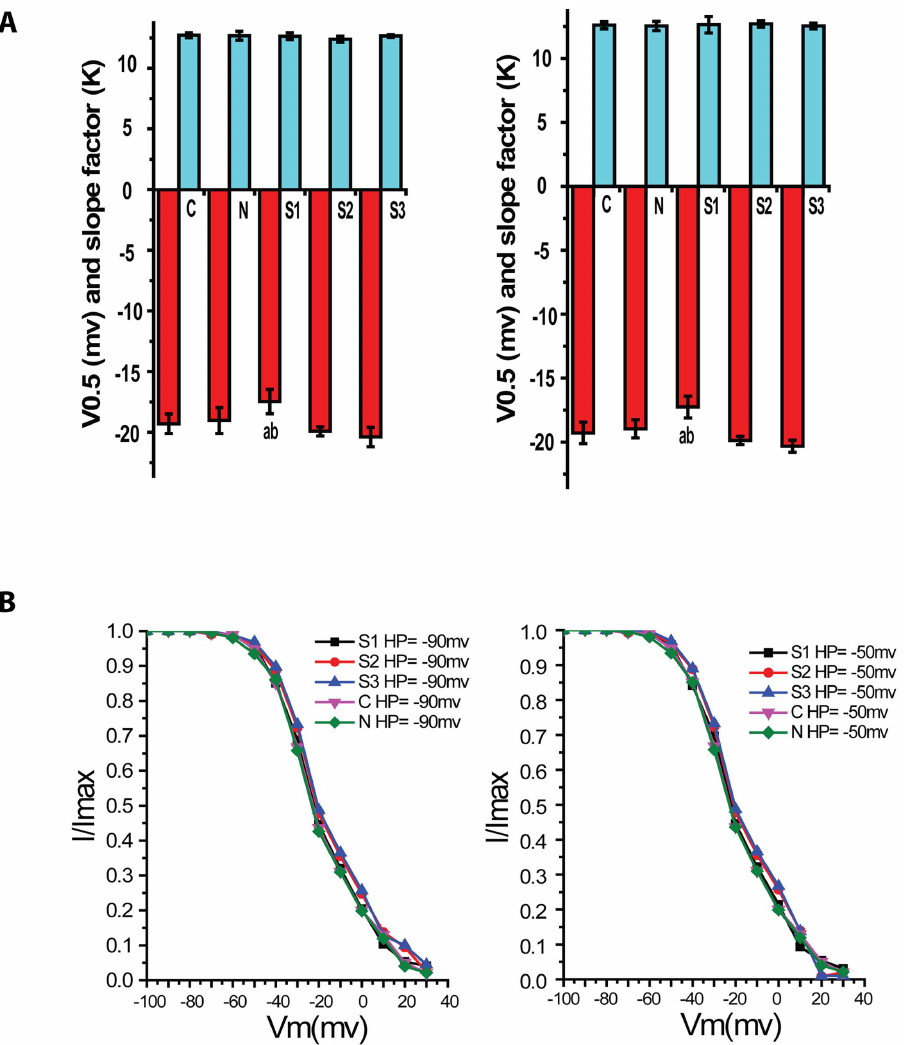
Figure 4. Voltage-dependent Ca + 2 channel currents in rabbit basilar artery smooth muscle cells after SAH. The graph A and B showed steady-state inactivation curves at HP of 2 90mV and 2 50mV respectively. The abscissa was voltage (mV) and the ordinate was relative conductivity (G). Compared with C group, steady-state inactivation curves of S1–S3 groups at HP of 2 90mV and 2 50mV shifted to the right, but it had only significant difference in S3 group (P , 0.05, n=8/group).